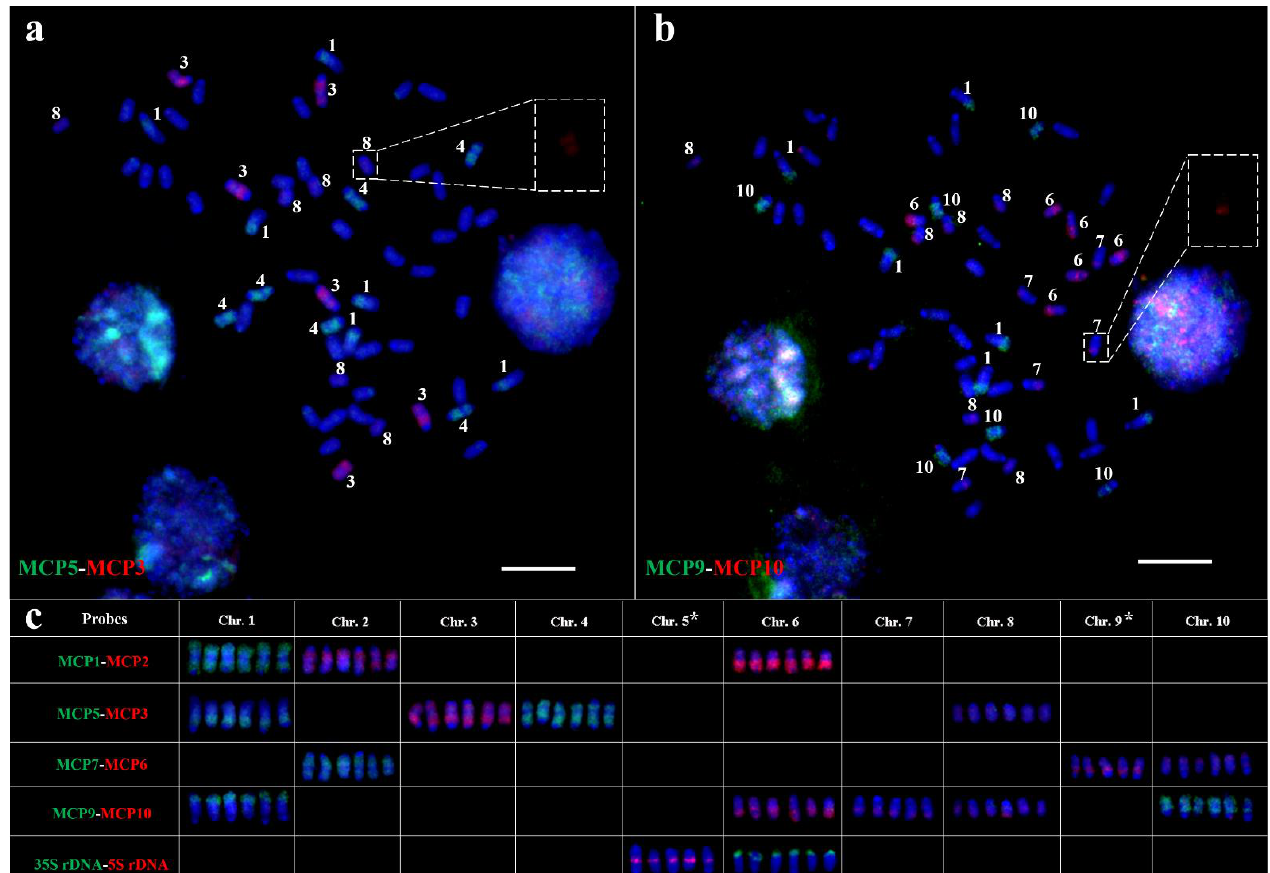
Figure 3. Sequential oligo-FISH identifying all 10 chromosomes on the same metaphase plate of T. arundinaceum . ( a ) Second round of oligo-FISH using MCP5 (biotin-green) and MCP3 (digoxigenin-red) probes. ( b ) Fourth round of oligo-FISH using MCP9 (biotin-green) and MCP10 (digoxigenin-red) probes. ( c ) Statistical results of different probes. Arabic numerals denote the chromosome numbers. The dotted box denotes the weak signals of chromosomes 8 and 7. The symbol * indicates chromosomes 5 and 9 were both missing one copy in this particular cell due to the preparation of the slides. The six copies of chromosomes 5 and 9 on metaphase plate are provided in Figure S3. Bar = 10 μm.